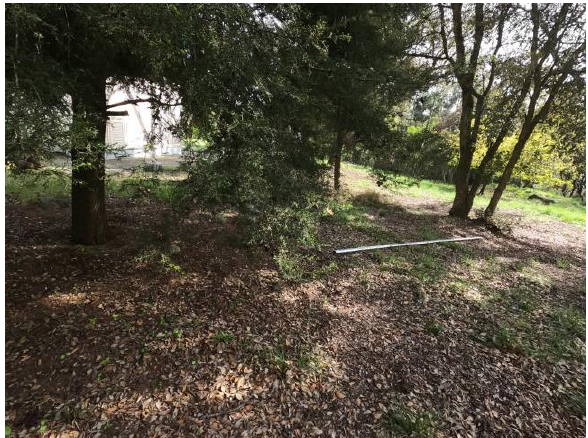
Figure 6 . Example of an image acquired in area covered by trees where the levelling staff is present The set of 4 tests were identified as B1 to B4. Camera positions were recorded for all of the images, except in the case of B4, in which only around half of the images were tagged with coordinates. This is something that operators should be aware of in the filed because the camera signalizes the correct functioning of the GPS. Figure 7 shows an aerial image of the area, with the camera horizontal GPS coordinates, which may look irregular because of the GPS accuracy.